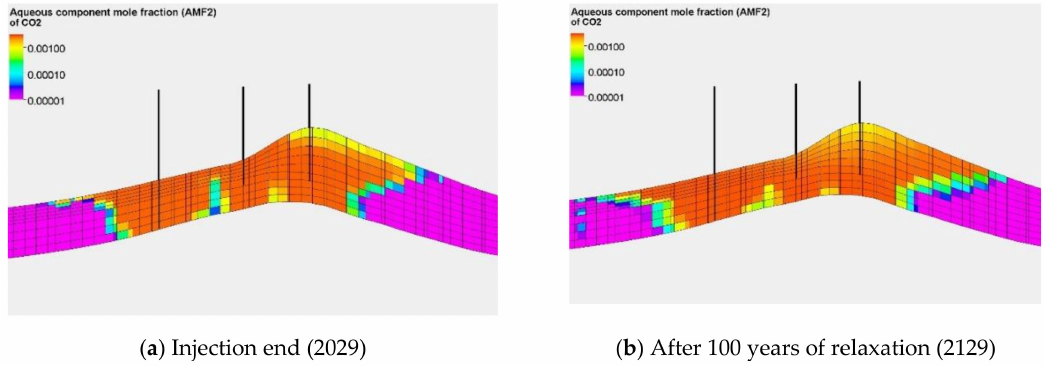
Figure 49. Distribution of brine saturation at the structure top.